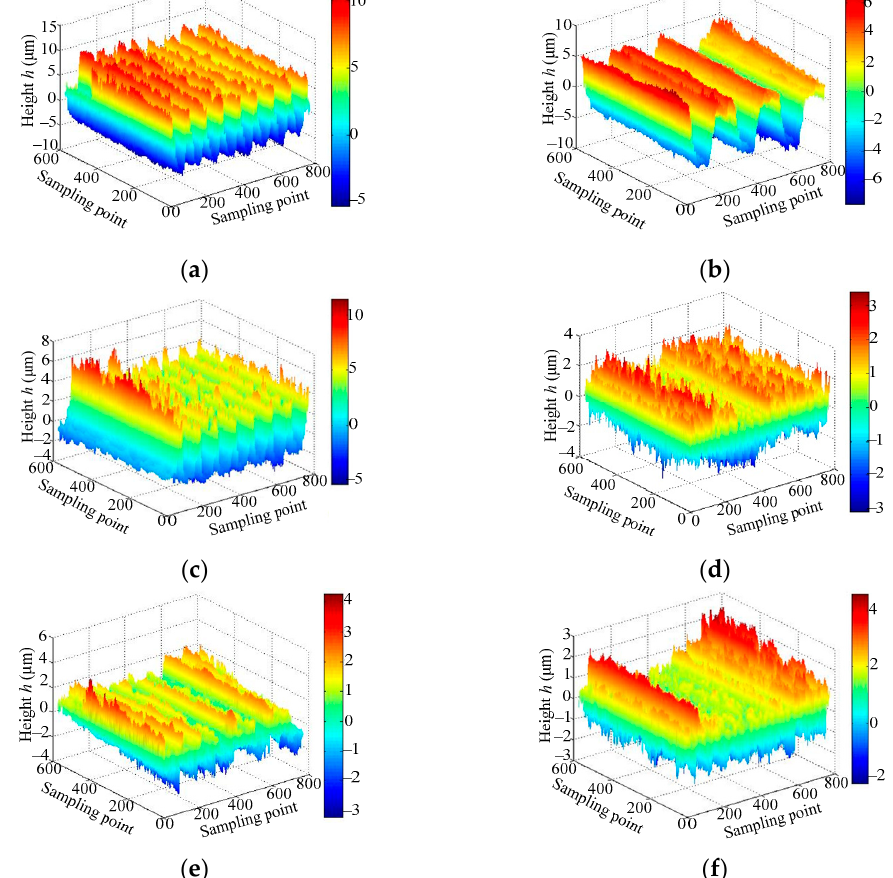
Figure 6. Measurement results of the sample surface topography: ( a ) Ra 3.2 turning; ( b ) Ra 3.2 plain milling; ( c ) Ra 3.2 boring; ( d ) Ra 0.8 turning; ( e ) Ra 0.8 plain milling; ( f ) Ra 3.2